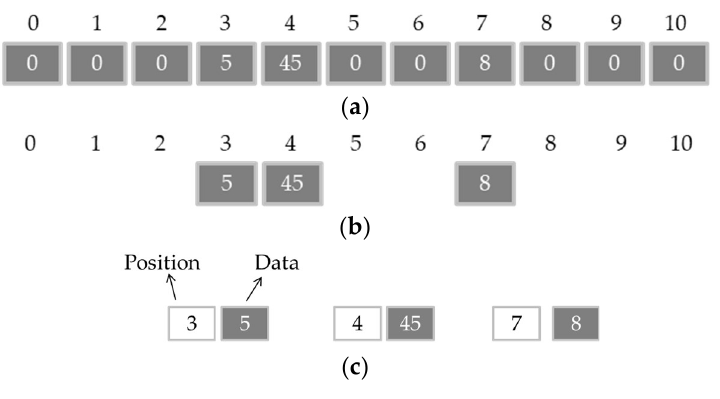
Figure 5. Cont. Figure 5.